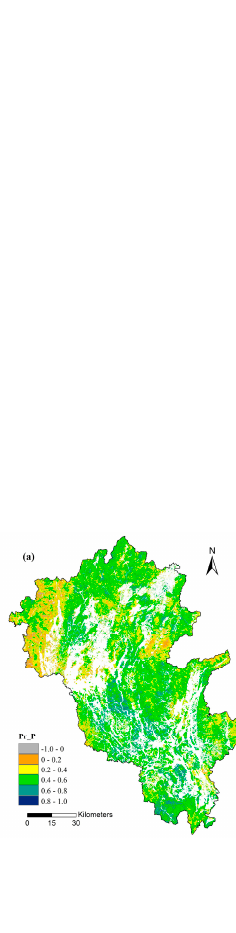
Table 4. Area percentage of different dominant factors on vegetation change (%).